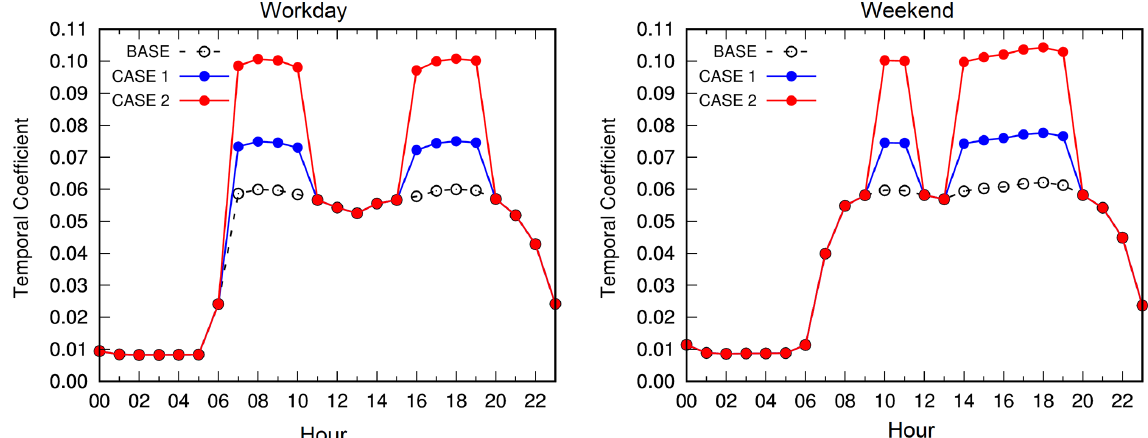
Figure 1. The VOC temporal coefficient in the hourly diurnal profile of all simulation cases on workdays and